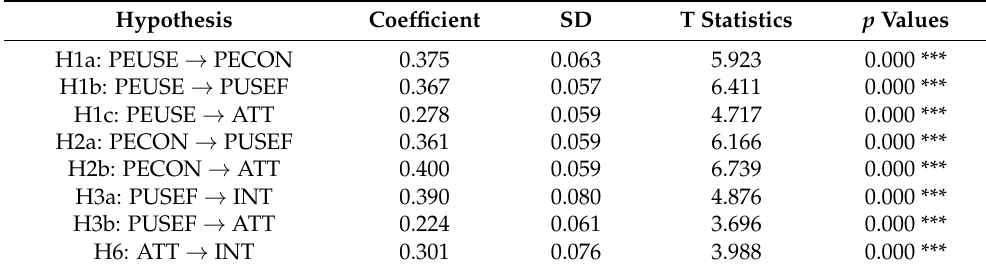
Table 5. Simple Base Line Model.